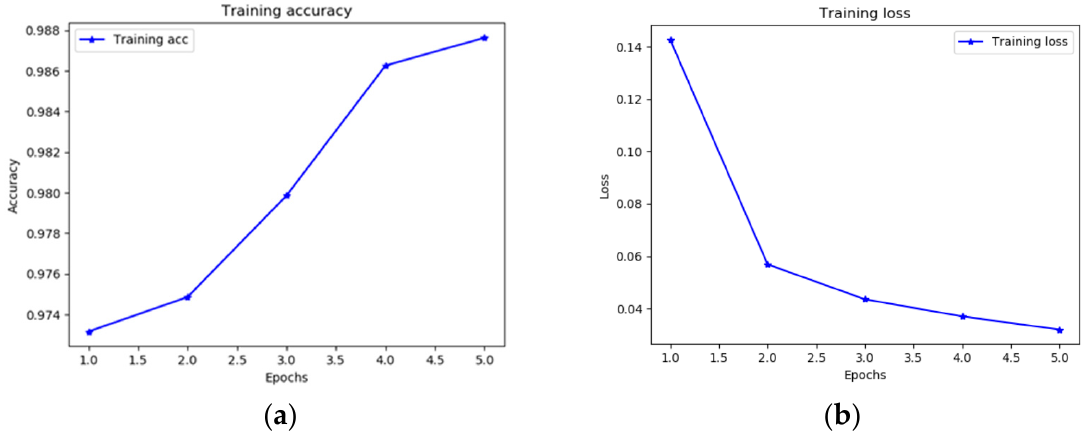
Figure 12. U-Net model training results. ( a ) The accuracy of self-predicted data. ( b ) The loss function of self-predicted data. Table 7. Training performance of the U-Net segmentation model.